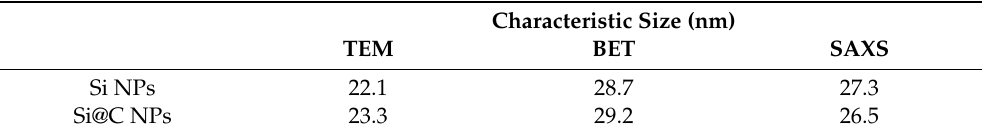
Figure 3. SAXS profiles log(I) vs. lo(Q) for ( a ) Si-GHG and ( b ) Si@C-GHG composite samples obtained by in-situ hydrothermal synthesis samples compared with the SAXS profile for the reference GHG graphene hydrogel. An insight into the scattering in the high Q range is provided by I(Q) 4 vs. Q plots for both Si-GHG ( c ) and Si@C-GHG ( d ) samples that highlight the contribution from individual Si and Si@C nanoparticles to the overall scattering. Table 1. Comparison of the various Si NPs and Si@C NPs diameters determined by either TEM, BET, or SAXS